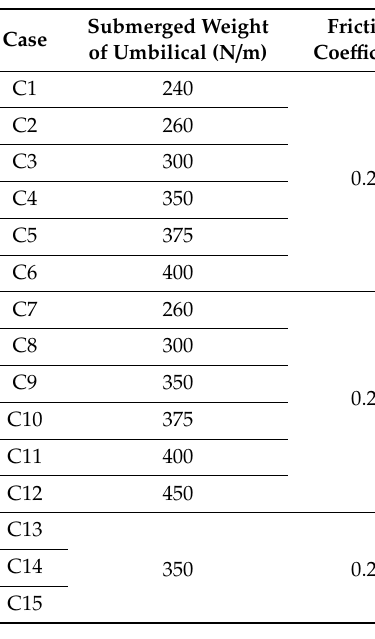
Table 5. The overview of analysis cases for